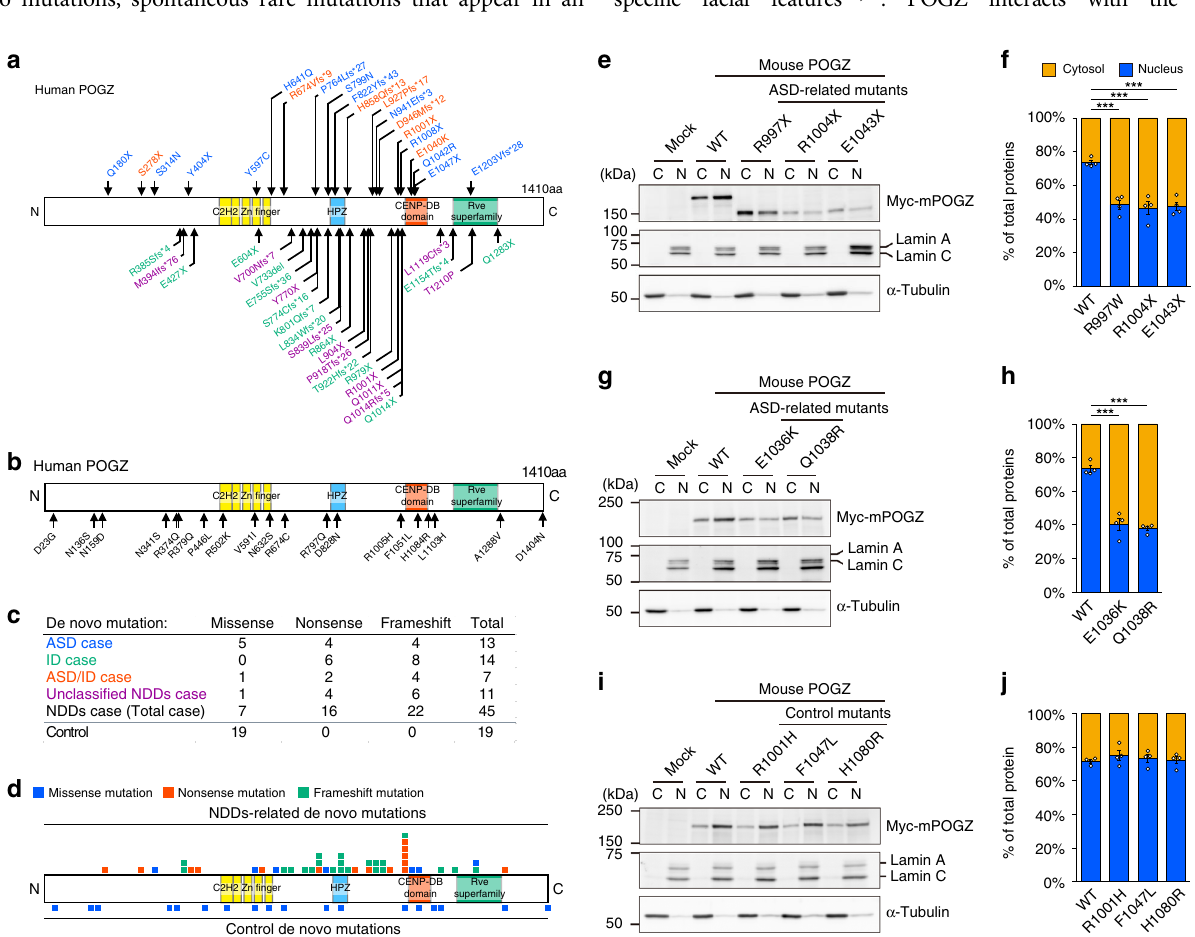
Fig. 1 ASD-related de novo mutations in POGZ impair the nuclear localization of the POGZ protein. a De novo mutations in POGZ identi fi ed in patients with NDDs (blue, ASD; green, ID; red, both ASD and ID; purple, unclassi fi ed NDDs). b De novo mutations in POGZ identi fi ed in unaffected controls. c The number of missense, nonsense, and frameshift mutations identi fi ed in patients with NDDs and unaffected controls. d Distribution of POGZ mutations identi fi ed in patients with NDDs and unaffected controls (blue, missense mutations; red, nonsense mutations; green, frameshift mutations). e , g ASD-related nonsense e or missense g mutations disrupted the nuclear localization of Myc-tagged overexpressed mouse (m) POGZ in Neuro2a cells. C cytosolic fraction; N nuclear fraction; WT wild-type. Note that Q1038R mutation in mouse POGZ corresponds to Q1042R mutation in human POGZ. f , h , j Quanti fi cation of POGZ in cytosolic and nuclear fractions (each n = 4). i Control mutations identi fi ed in unaffected healthy controls did not affect the nuclear localization of Myc-tagged overexpressed mouse POGZ in Neuro2a cells. C cytosolic fraction; N nuclear fraction; WT wild-type. Note that the amino acid numbers are based on the human protein (NP_055915.2) a , b and mouse protein (NP_766271.2) e , g , i . f , h , j One-way ANOVA with Bonferroni – Dunn post hoc tests, f F 3, 12 = 23.12; h F 2, 9 = 67.45; j F 3, 12 = 0.491. *** P < 0.001. Data are presented as the mean ± s.e.m. The source data underlying fi gures e , g and i are provided as a Source Data fi